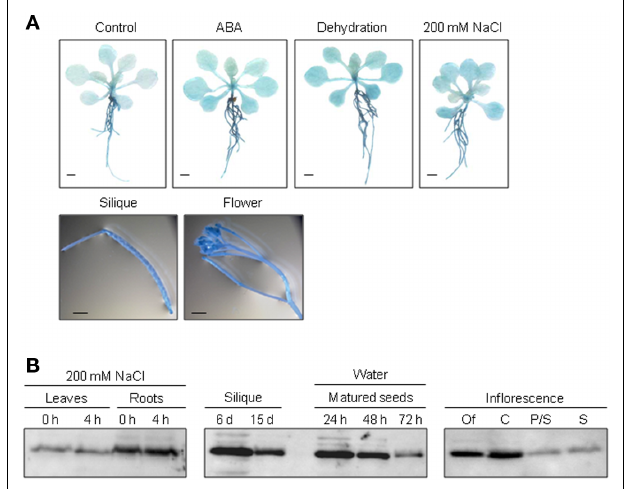
FIGURE 2 |Tissue specific expression ofALDH22A1 inArabidopsis. (A) ALDH22A1::GUS expression in transgenic Arabidopsis plants: 4-week-old (approximately eight rosette leaves) transgenic Arabidopsis seedlings were subjected to ABA (100 μ M), dehydration or salt stress (200mM NaCl) for a period of 4h and analyzed for in situ GUS activity. Bars represent 1mm. (B) Total proteins (20 μ g) from leaves and roots of salt-stressed and control plants as well as from different flower tissues were separated on a 12% (w/v) SDS-PAGE and blotted onto a nitrocellulose